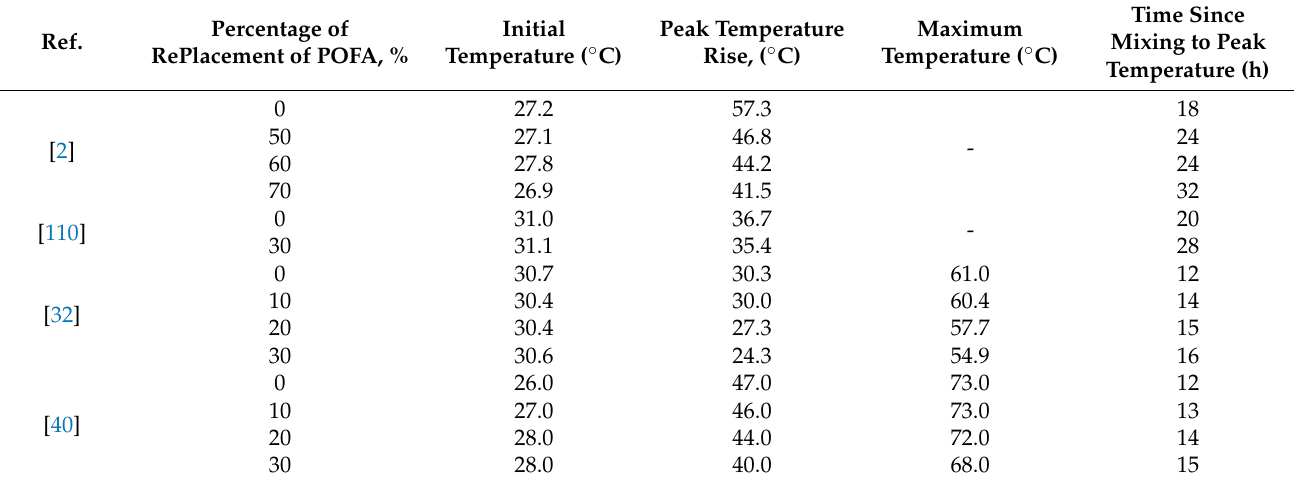
Table 4. Temperature variations caused by HoH in POFA-based